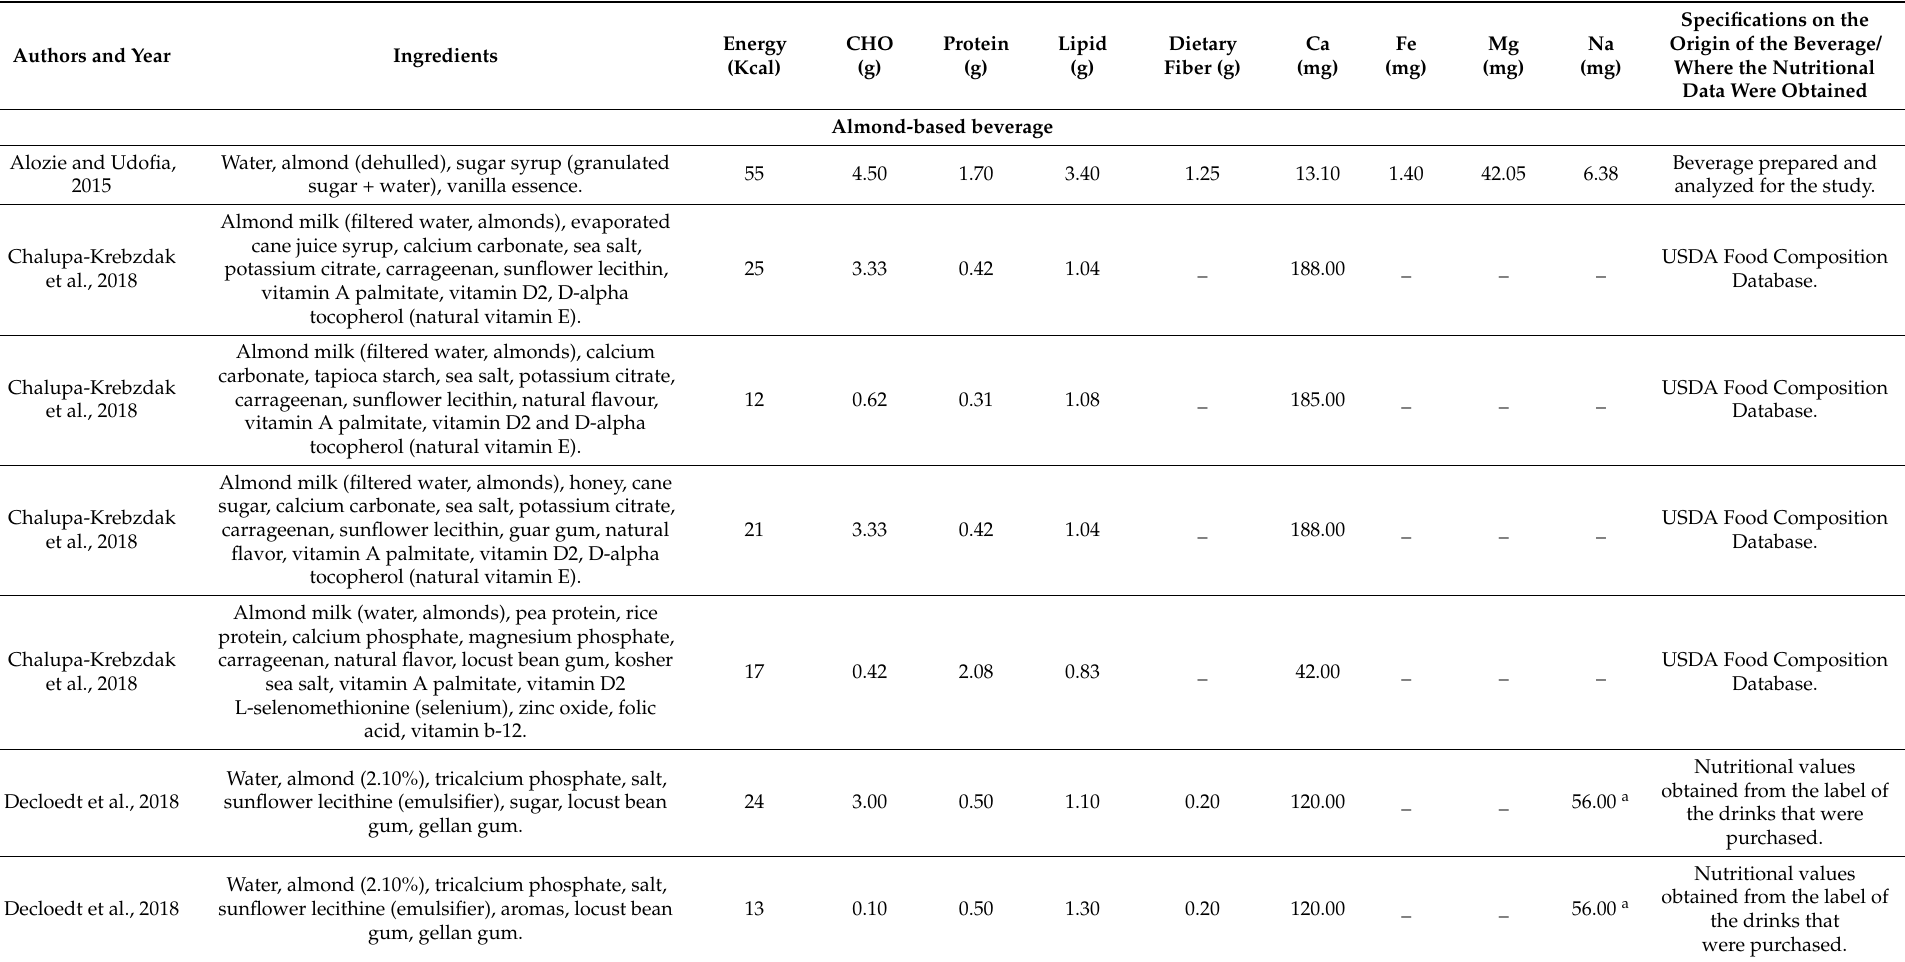
Table 1. Table of nutritional composition (per 100 mL), ingredients and specifications on the origin of plant-based beverages from scientific studies selected according to the inclusion and exclusion